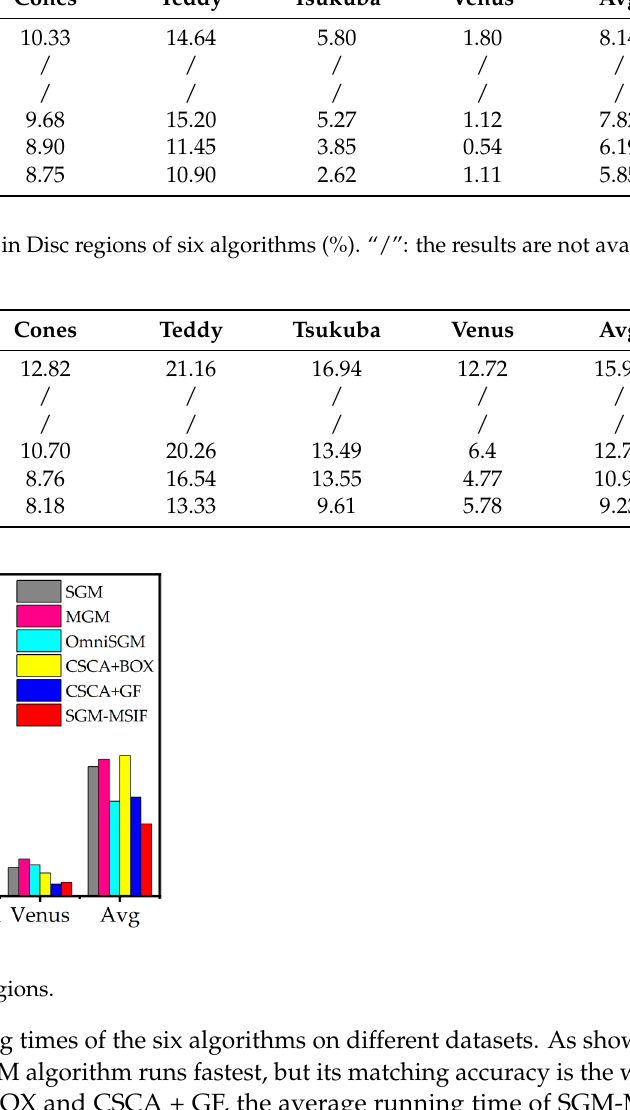
Table 5. Comparison of the running time of four algorithms (s). “/”: the results are not available in the references.